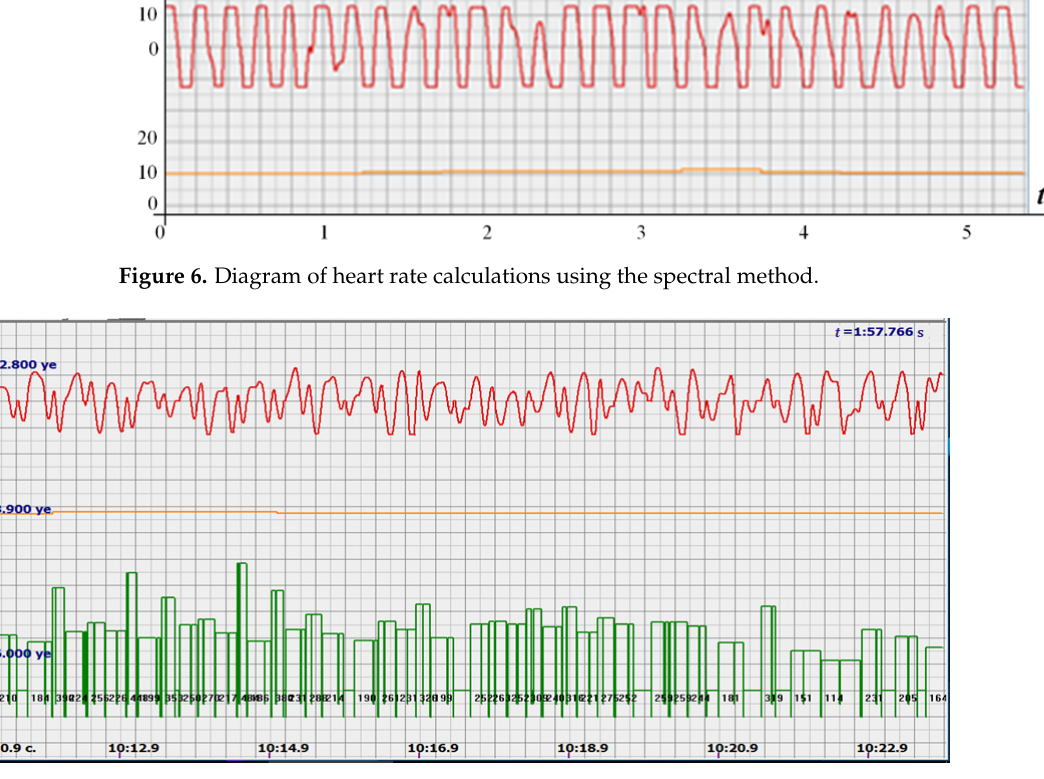
Figure 7. Diagram of an ultrasonic signal during fetal movement.